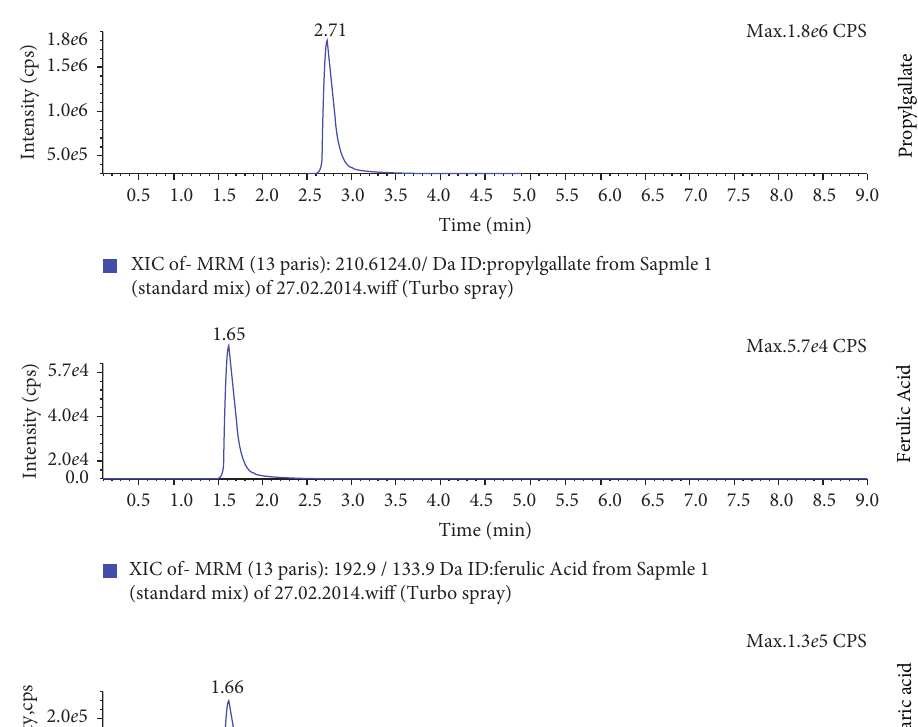
XIC of- MRM (13 paris): 162.7/ 118.8 Da ID: p -Coumaric acid from Sapmle 1 (standard mix) of 27.02.2014.wiff (Turbo spray)